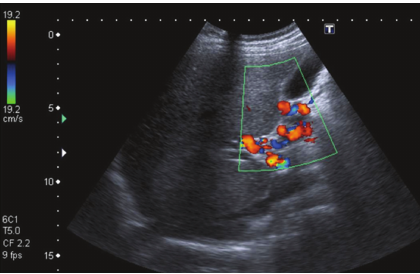
Figure 4: Color Doppler ultrasound image demonstrates multiple tortuous venous structures in the hepatic hilum, keeping with the cavernomatous transformation of the portal